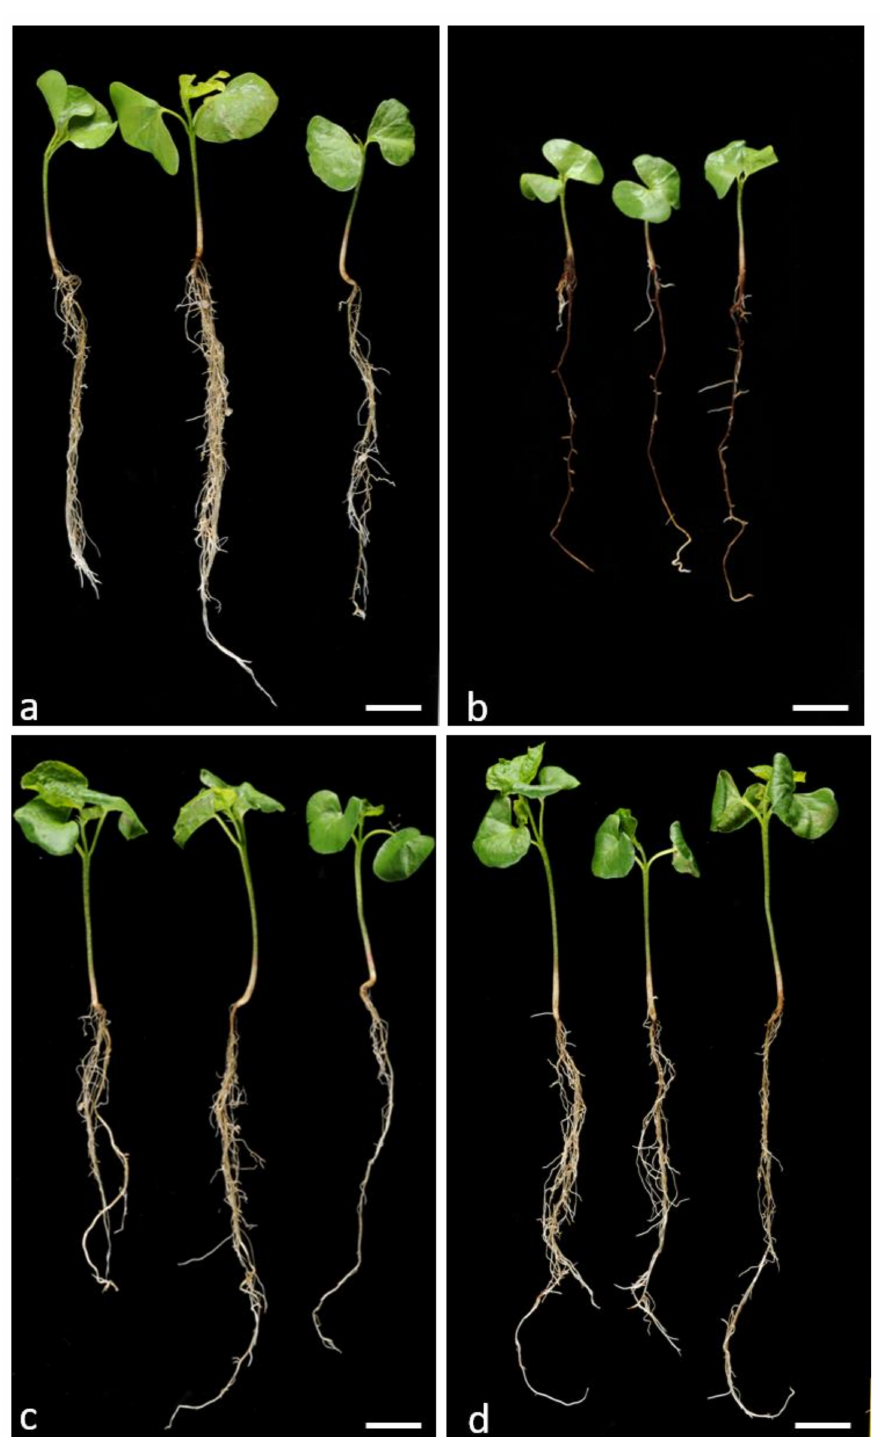
Figure 1. Parental phenotypes of the black root rot (BRR)-susceptible YZ uninfected ( a ) and infected ( b ) and resistant BM13H uninfected ( c ) and infected ( d ) seedlings 25 days after germination in soil without ( a , c ) and with ( b , d ) BRR spores. Bars = 2